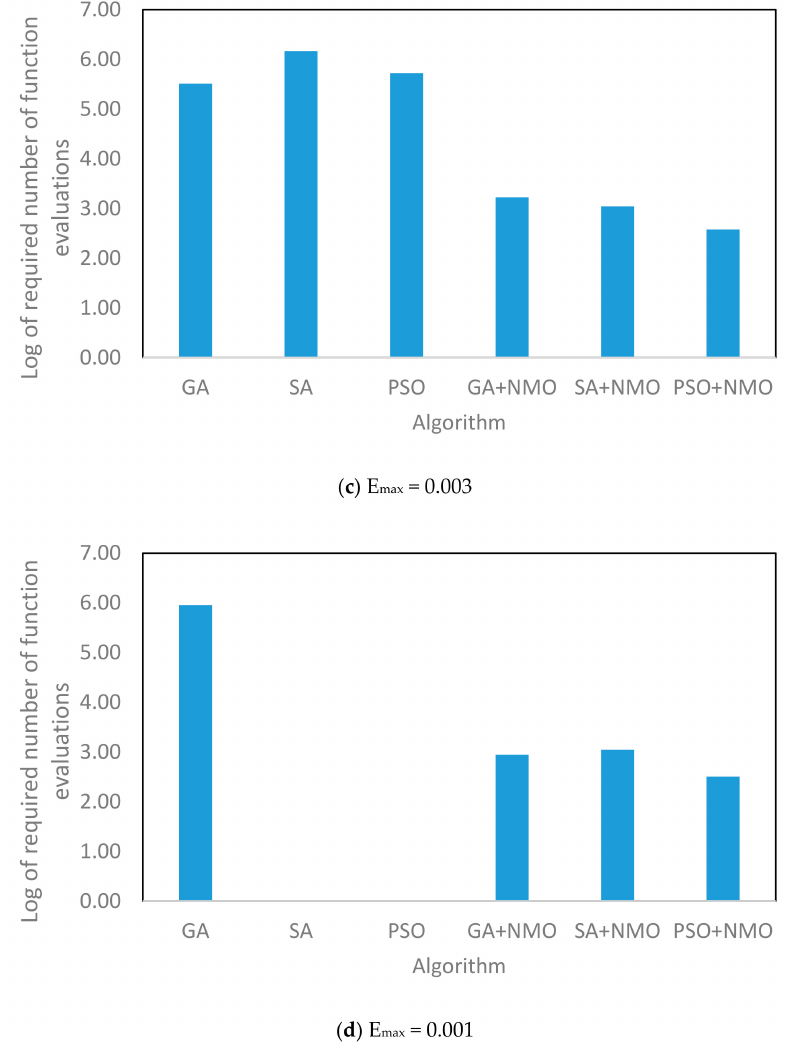
Figure 15. Comparison of number of ANN evaluations required to obtain di ff erent error levels by di ff erent